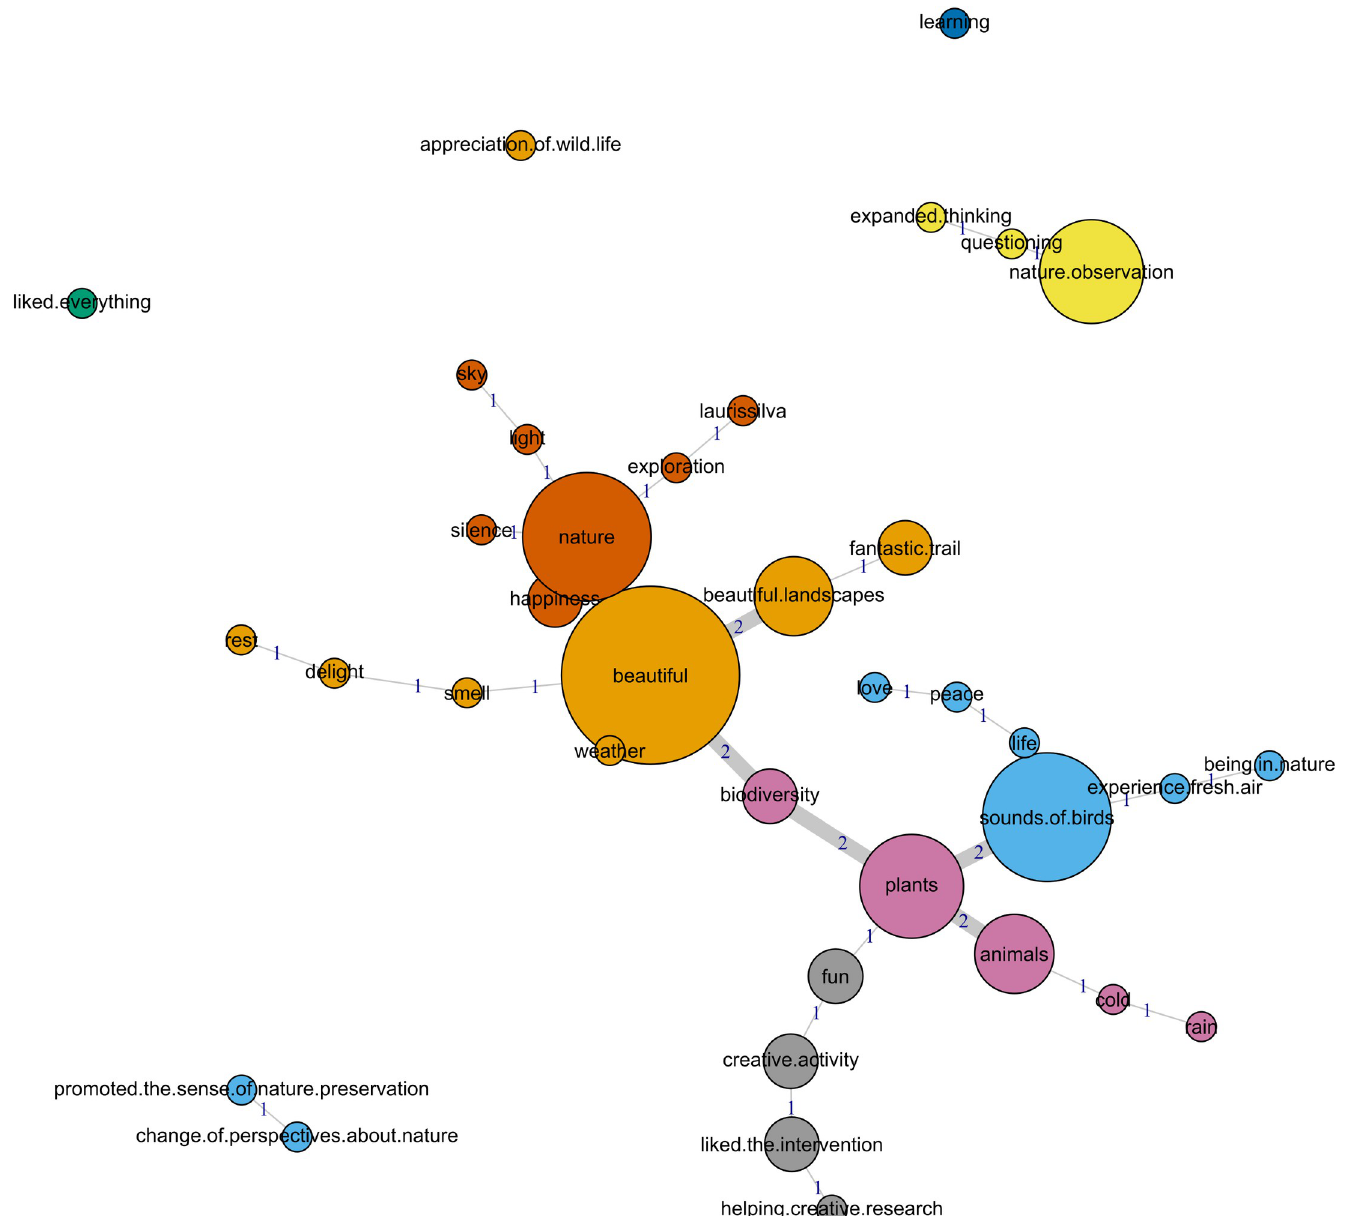
Fig 13. Results of the lexical similarity analysis representing the relationships between the 34 responses to the final free, open-ended activity. Line thickness and numbers correspond to the frequency of co-occurrence, circle sizes to evocation frequency, and each color aggregates clusters of